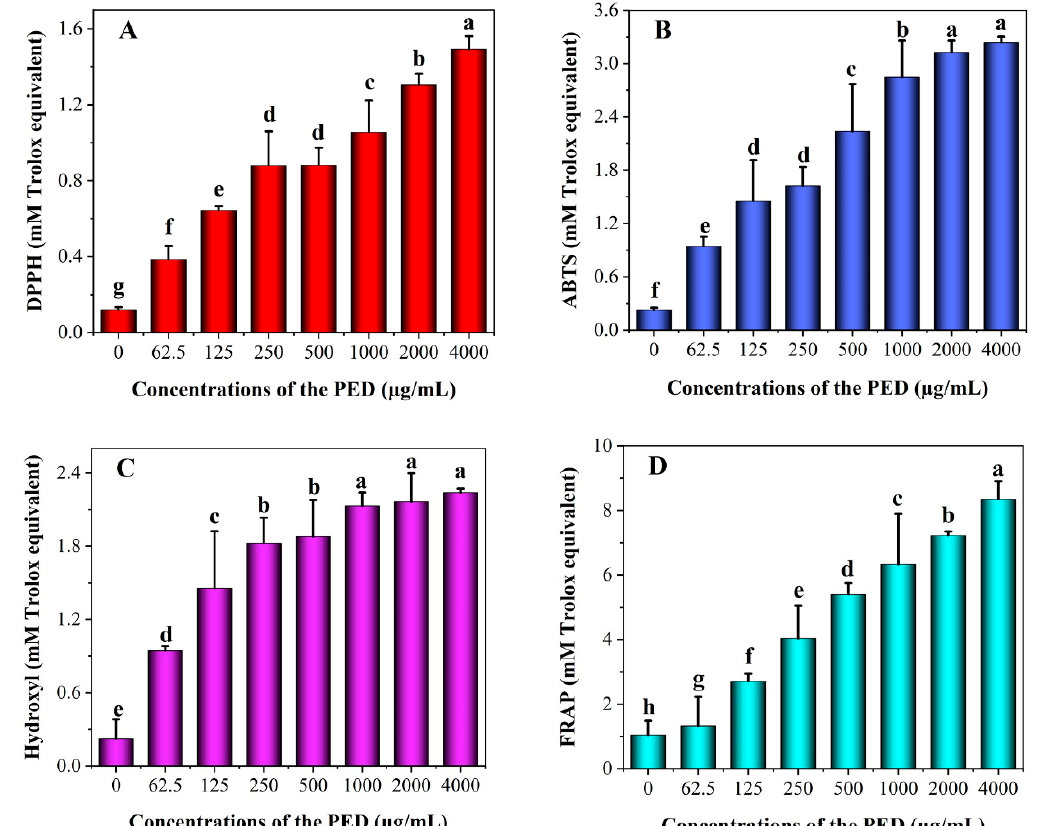
Figure 4. Antioxidant activity of PED in different concentrations (t = 4 h). ( A ): DPPH; ( B ): ABTS; ( C ): Hydroxyl; ( D ): FRAP. Bars indicate standard error (±SD). Different lowercase letters indicate significant differences ( p < 0.05).